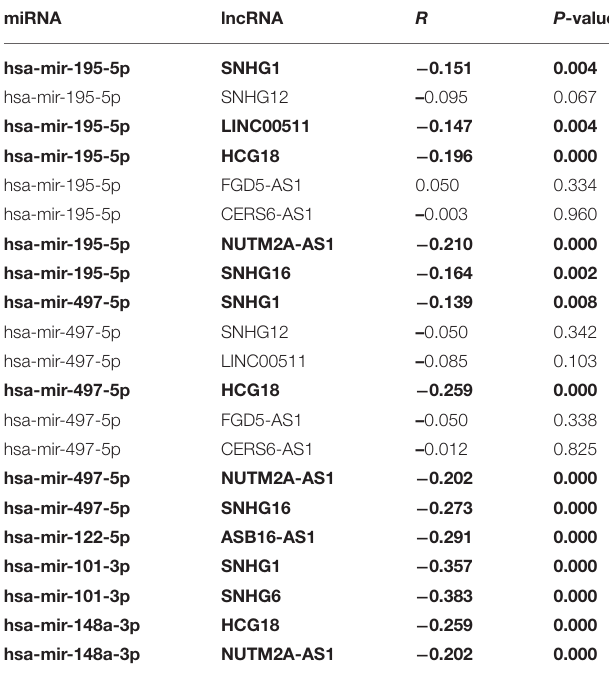
TABLE 3 | The correlation between potential miRNA-lncRNA pairs identified by starBase (The pairs conformed to the ceRNA hypothesis are marked with Bold type